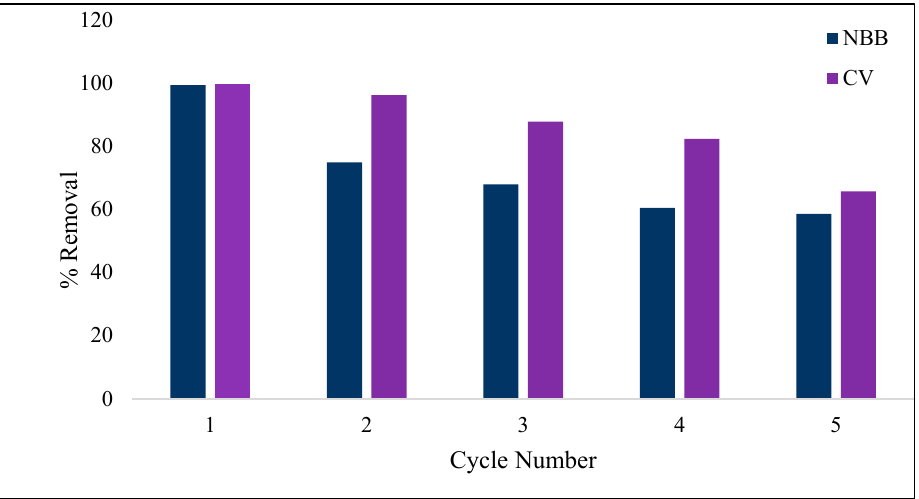
Figure 13. Reusability of ACOC for adsorption of NBB and CV.